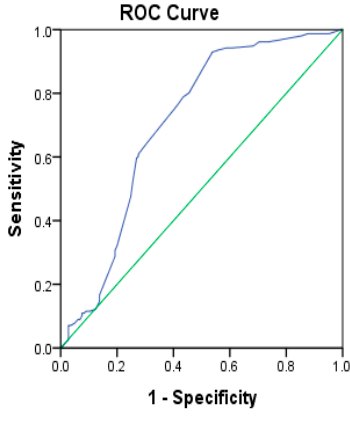
Figure 1. ROC curve of vitamin D.